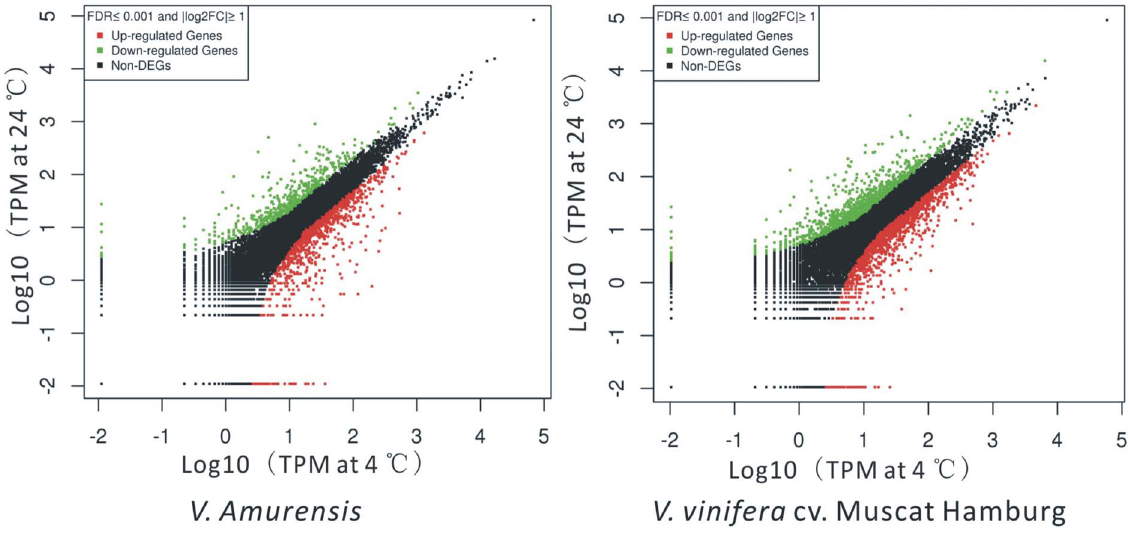
Figure 1. Identification of differentially expressed genes (DEGs) under cold treatment in V.amurensis and V.vinifera cv. Muscat of Hamburg. TPM (tags per million clean tags) were used to represent the expression levels of genes in non-cold treatment (NCT) and cold-treatment (CT) libraries in two grape varieties. Two parameters, ‘‘FDR , 0.001’’ and ‘‘|log2 Ratio| $ 1’’ were used as the threshold to evaluate the significance of gene expression difference. Red and green dots represent the up- or down-regulated transcripts, respectively, during cold treatment in V. amurensis and Muscat of Hamburg. Black dots indicate transcripts without significant changes under cold stress.